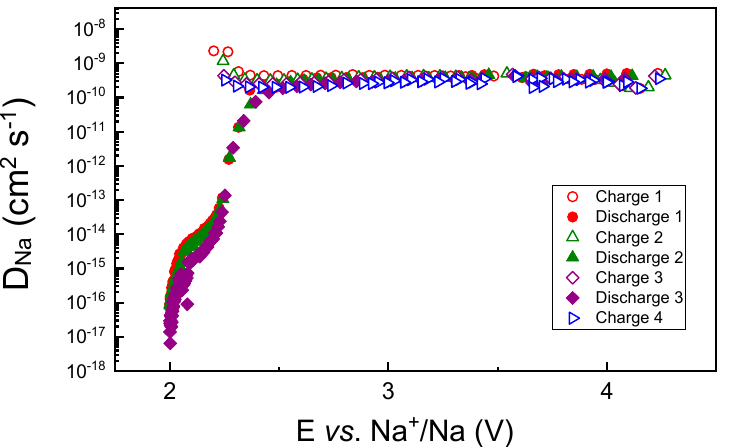
Figure 3. Chemical diffusion coefficients of Na + in Na 0.8 Co 0.8 Ti 0.2 O 2 , obtained by GITT measurements during the first several charge—discharge cycles.